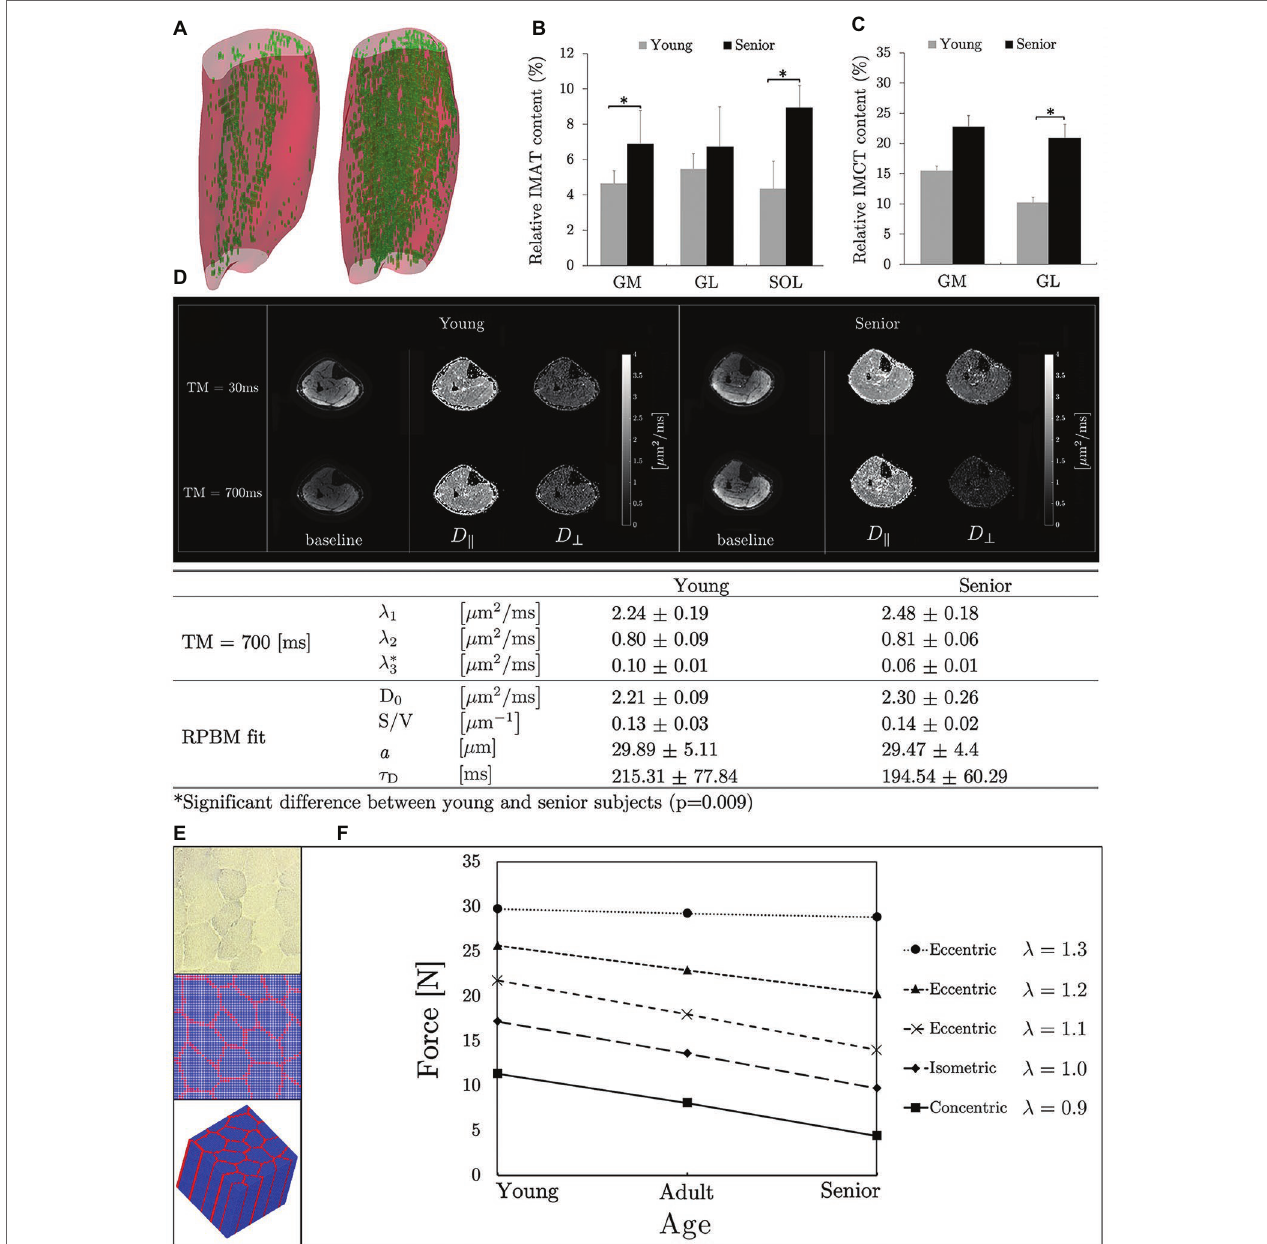
FIGURE 1 | 3D muscle volumes with the noncontractile tissue shown segmented (automated MCFCM algorithm) in green for a young (left) and aging (right) subject (A) reproduced with permission from Wiley publisher of Ugarte et al. (2017a). Box plots reproduced with permission from Springer publisher of Csapo et al. (2014) showing adipose (B) and connective tissue (C) content in young and aging subjects in the calf muscles (MG, medial gastrocnemius; LG, lateral gastrocnemius; SOL, soleus). Significant differences are marked by an asterisk. Baseline and eigenvalue (D || and D ) images shown at two diffusion times (short: 30 ms and long: ⊥ 700 ms) for young and aging subjects (D) . Tertiary eigenvalues decrease with diffusion time and are significantly different between young and aging subjects at longer diffusion times indicating that at these longer times when the average diffusion path length approaches fiber cell dimensions, the tertiary eigenvalue representing diffusion in the fiber cross-section is more sensitive to the fiber dimensions. The significant difference may potentially indicate that aging muscle fiber has a smaller diameter than young muscle fiber (D) reproduced with permission from ISMRM publisher of Malis et al. (2019a). Microstructural parameters of the model ( D 0 , free diffusion coefficient; S / V , surface to volume ratio of fibers; a , muscle fiber diameter; and τ D , residence time, which is the average time spent within a muscle fiber) for young and aging subjects (D) . Histological image of muscle tissue (top), segmented cross-section (middle), and 3D model produced by extruding the 2D model along the z -direction (blue: muscle fiber, red: connective tissue) (E) reproduced with permission from Wiley publisher of Zhang et al. (2019). The micromechanical model prediction of force generated by three muscle types (young, adult, and old) is shown for isometric, concentric, and eccentric contractions. Young, adult, and old muscle tissue were modeled with passive stiffness as low, medium, and high and connective tissue thickness as thin, medium thick, and thick, respectively; λ is the stretch ratio (F) reproduced with permission from Wiley publisher of Zhang et al.